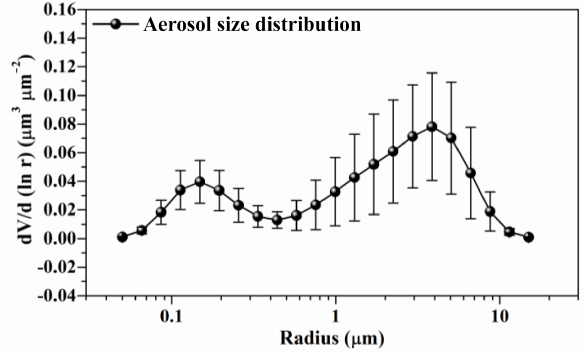
Figure 6. Composite volume size distribution of aerosols over Pune during